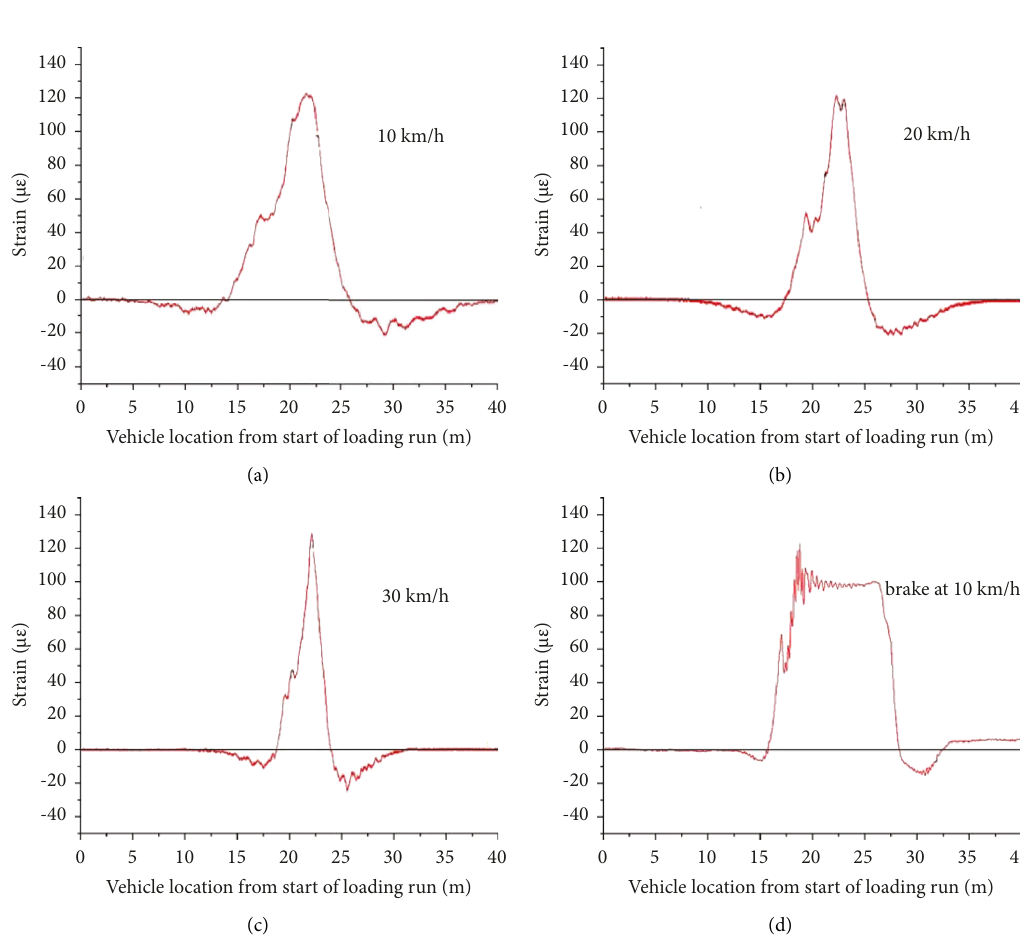
Figure 10: Measuring point arrangement.